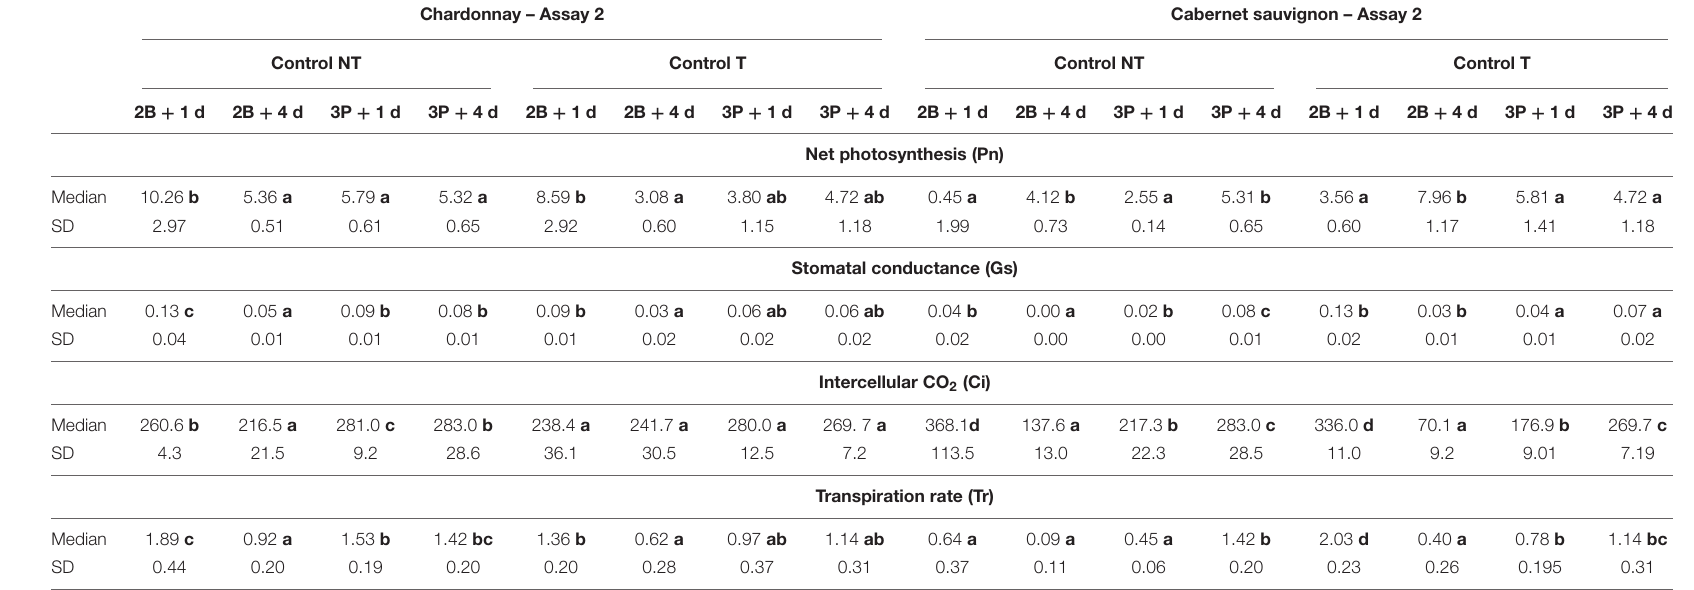
TABLE 3 | Kinetics of photosynthetic values (Pn, Gs and Tr) and main statistical parameters (median and standard deviation) recorded during Assay 2 one ( + 1d) and four ( + 4d) days after the second (2B) and third (3P) treatment on non-inoculated vines “Chardonnay” and “Cabernet